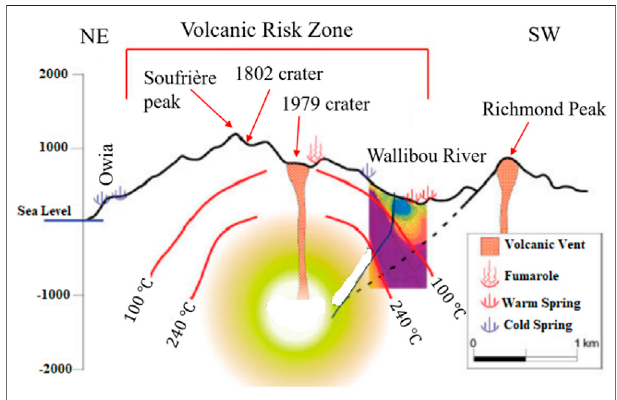
FIGURE 2 | Reconstructed conceptual model of St. Vincent geothermal reservoir. This Figure has been reconstructed with permission granted from Reykjavik Geothermal Limited (Source: Reykjavik Geothermal,